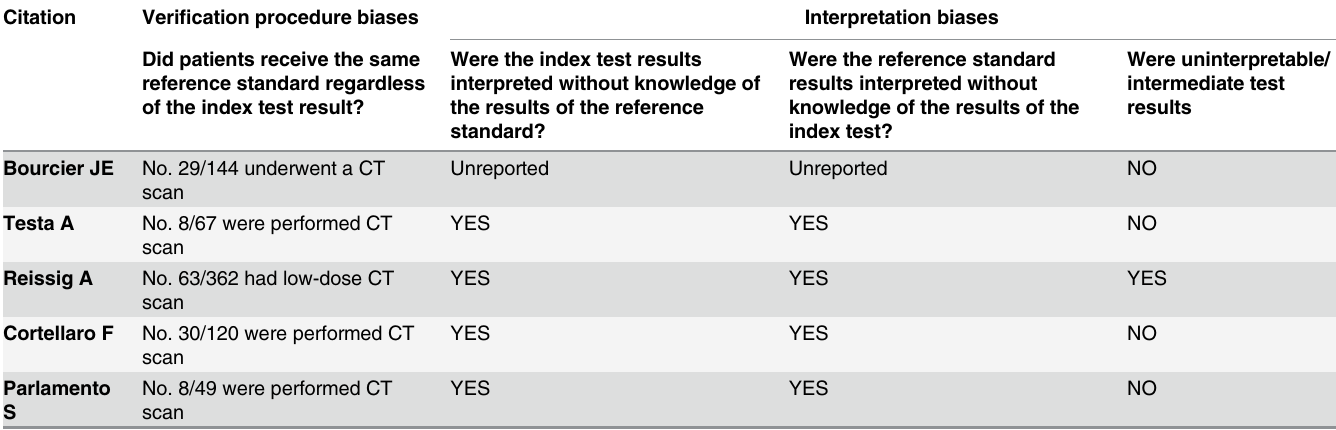
Table 2. Details of quality assessment by the QUADAS tool.